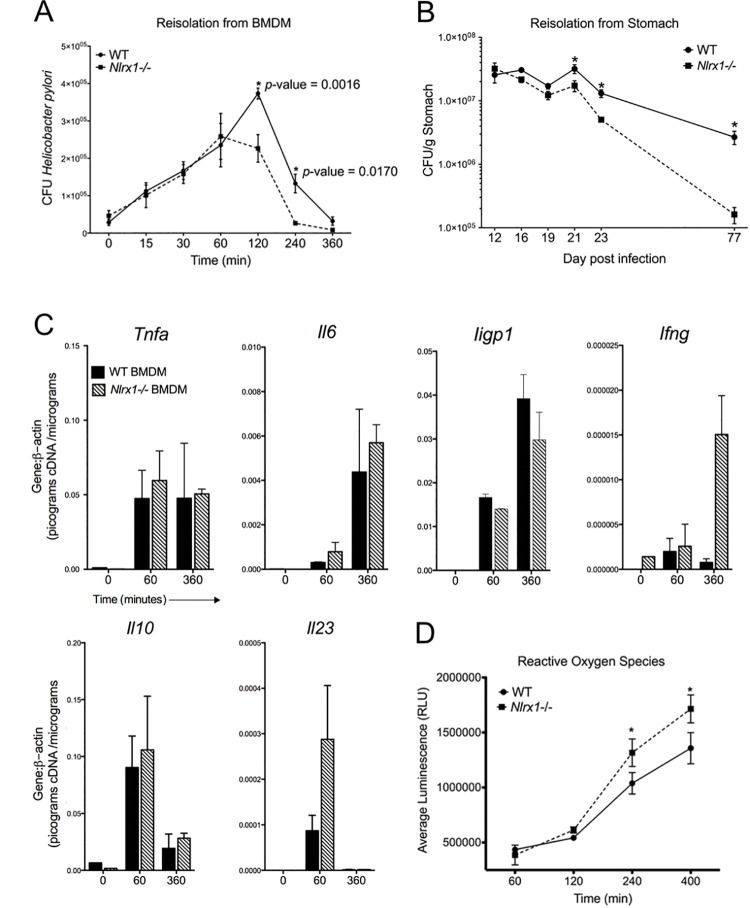
Experimental validation studies confirm role for NLRX1 in Helicobacter pylori burden and host immunity.Bone marrow derived macrophages were obtained from wild type and Nlrx1-/- mice then challenged with H. pylori using the gentamycin protection assay. Cells were collected incrementally from 0 to 360 minutes post co-culture and assayed for intracellular H. pylori replication via re-isolation (n = 3) (A), gene expression via quantitative real-time RT-PCR (C), or production of reactive oxygen species (n = 3) (D). Stomachs from H. pylori infected mice were collected from 12 to 77 days post infection and bacterial burden was determined via re-isolation (n = 7) (B). Asterisk indicates P-value < 0.05 based on ANOVA.